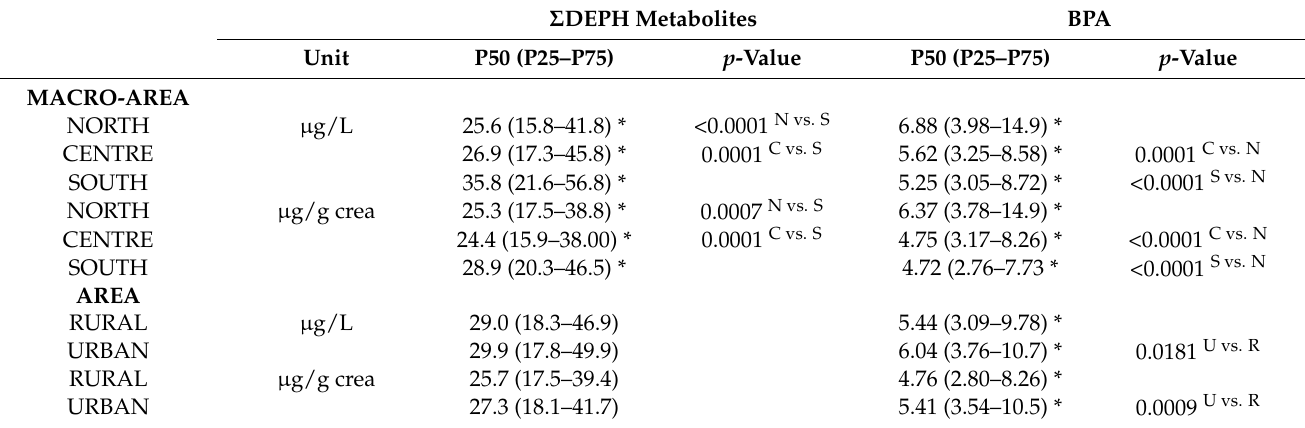
Table 3. Levels of the sum of DEHP metabolites in urine samples of women residing in the north (N = 300), centre (N = 299), or south (N = 299) of Italy. In the table are reported the median (P50) with the interquartile (P25–P75) range for both unadjusted ( µ g/L) and creatinine-adjusted concentrations ( µ g/g).